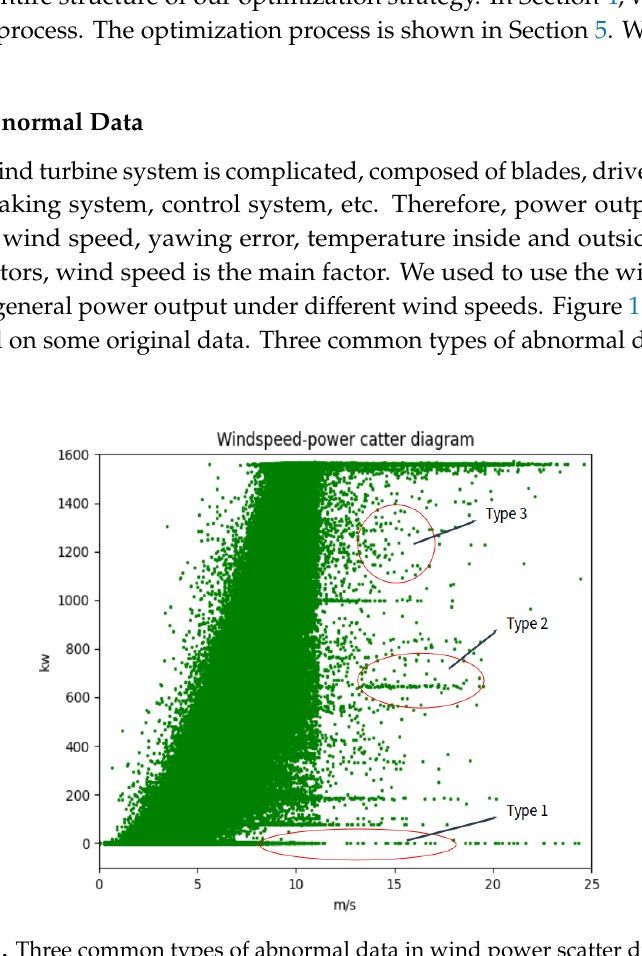
Figure 1. Three common types of abnormal data in wind power scatter diagram.